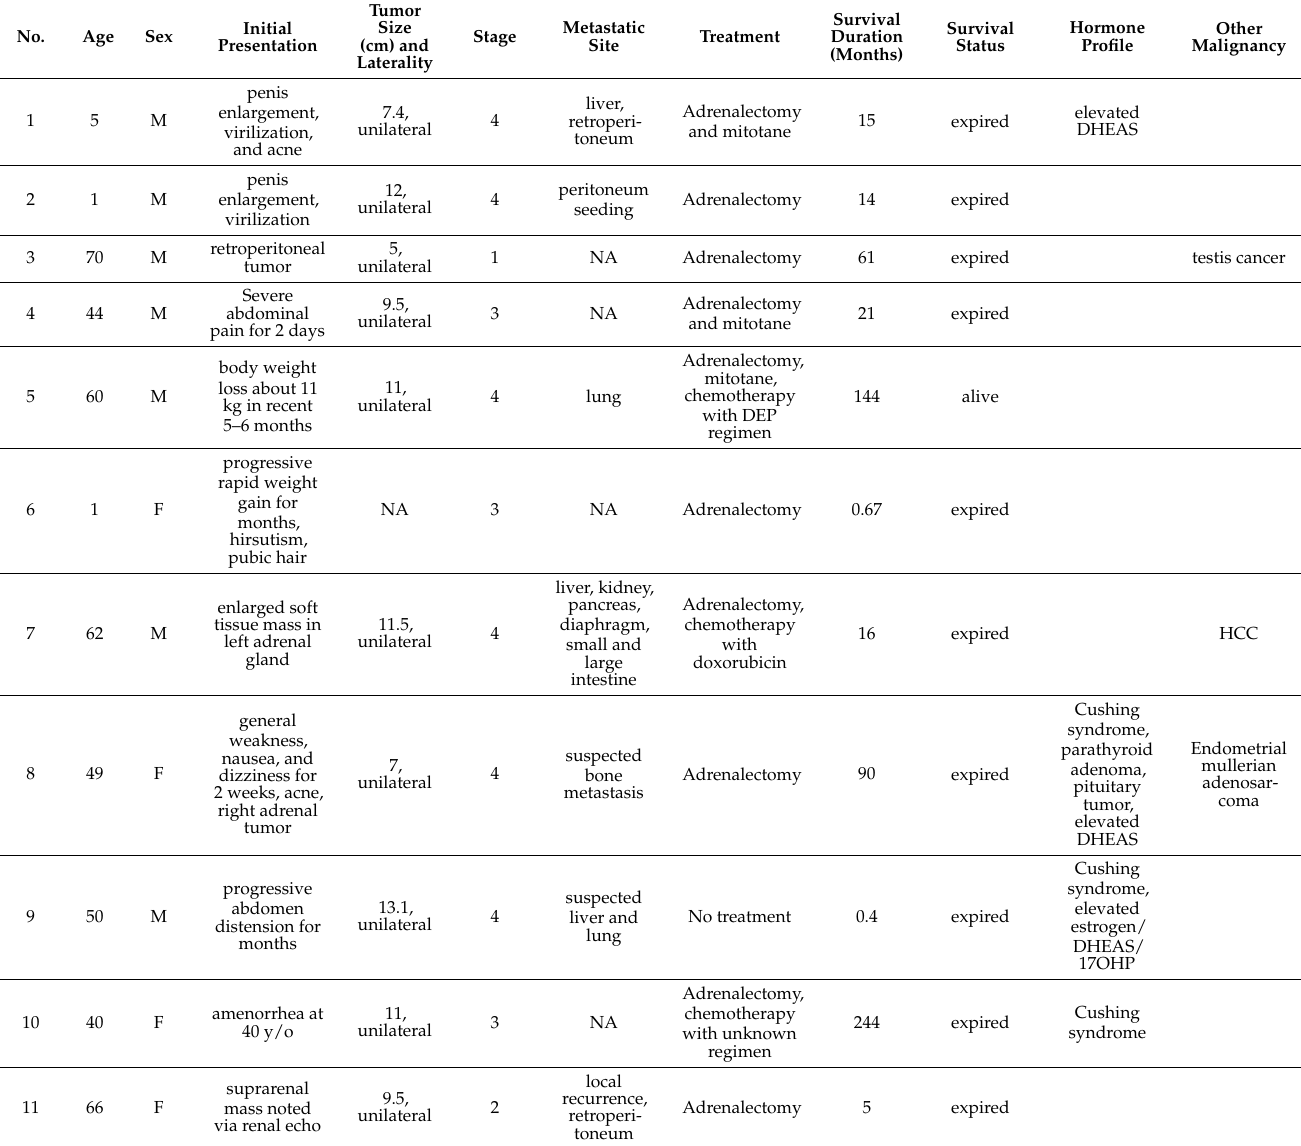
Table 1. Clinical presentation of 14 patients with